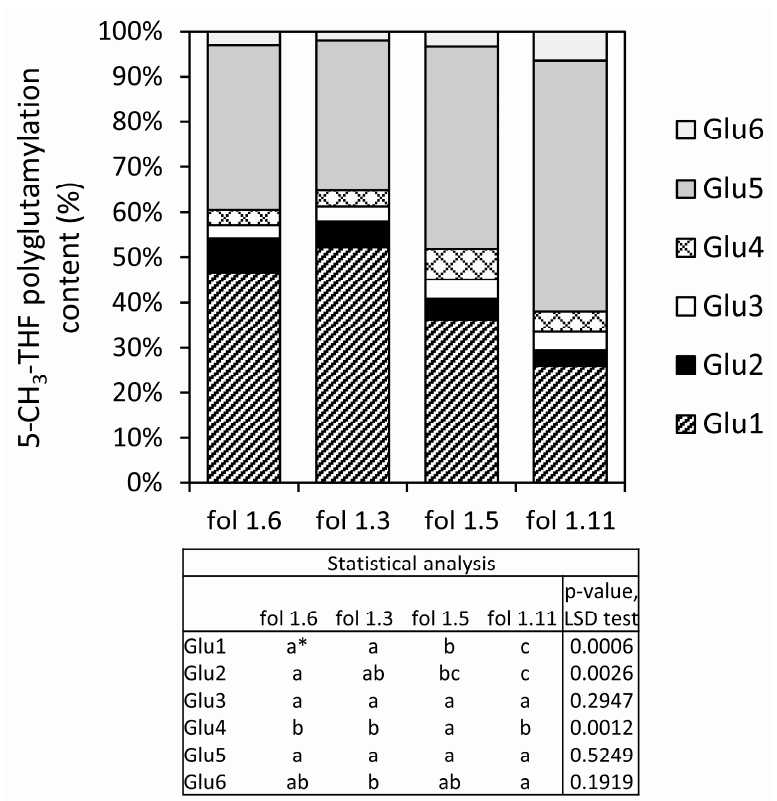
Figure 3. Glutamylation profile of 5-CH 3 -THF in high and low folate clones. * Di ff erent letters in the same row are significantly di ff erent (Least Significant Di ff erence test, p < 0.05) and are based on three independent determinations.